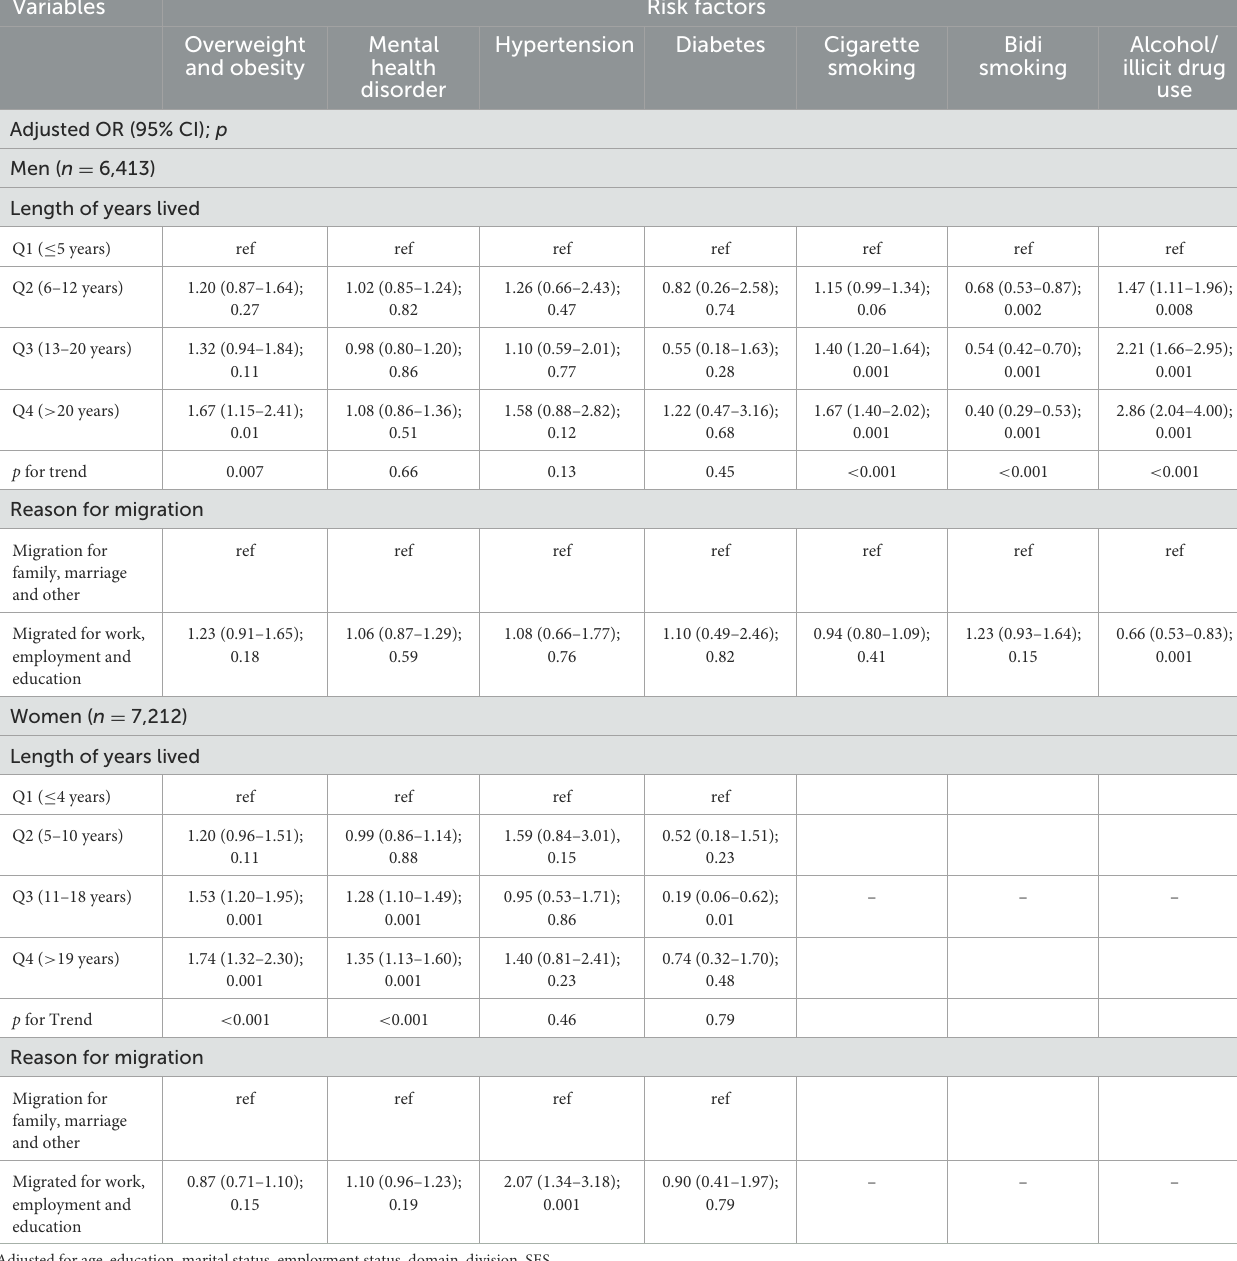
TABLE 4 Length of urban years and reasons for migration and their association with CVD risk factors among rural-to-urban migrant men and women.